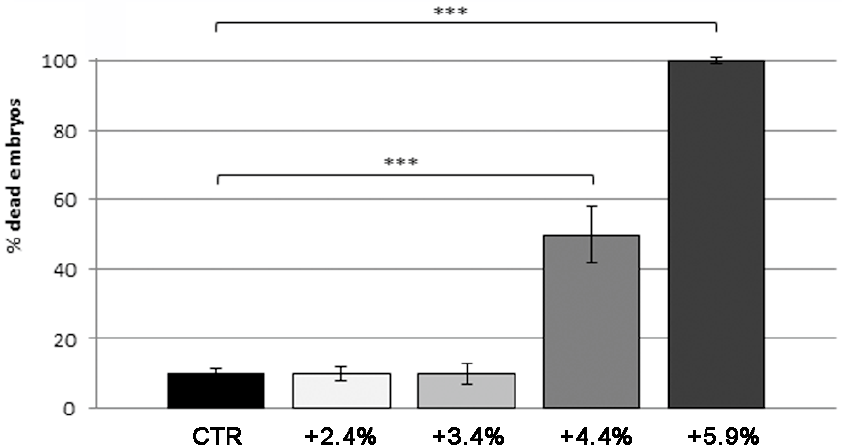
Figure 2. Mortality rate of embryos grown under different increases in hydrostatic pressure (HP) from 0% (CTR) up to 5.9% evaluated at five days post fertilization. Hydrostatic pressure increase is indicated to be safe for embryos up to 3.4%, whereas a 4.4% HP increase enhances the mortality at 49%. Further, a 5.9% HP increase is lethal for all embryos (CTR vs. +4.4% HP, *** p < 0.001; CTR vs. 5.9% HP, *** p < 0.001).